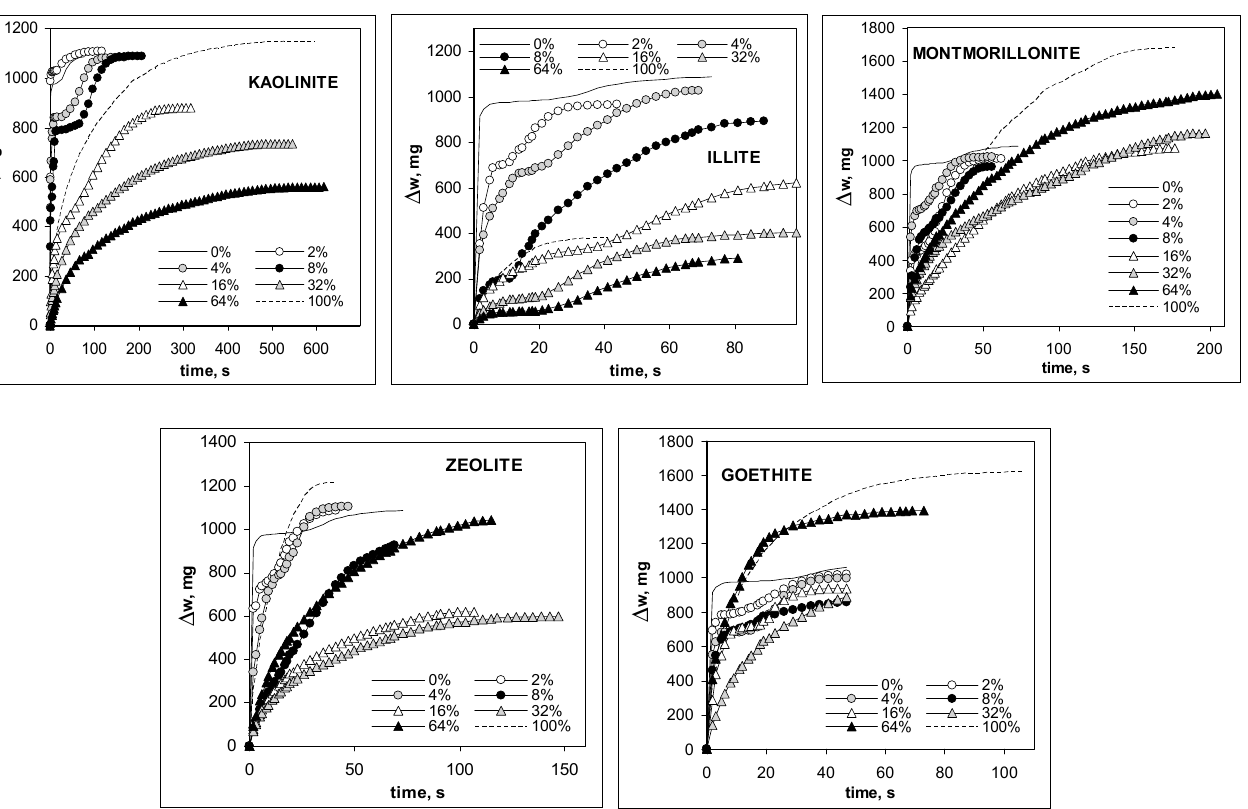
Figure 4. Exemplary aggregate destruction curves show changes in the silt aggregates’ weight in time after fast wetting as dependent on the kind and content of the minerals.